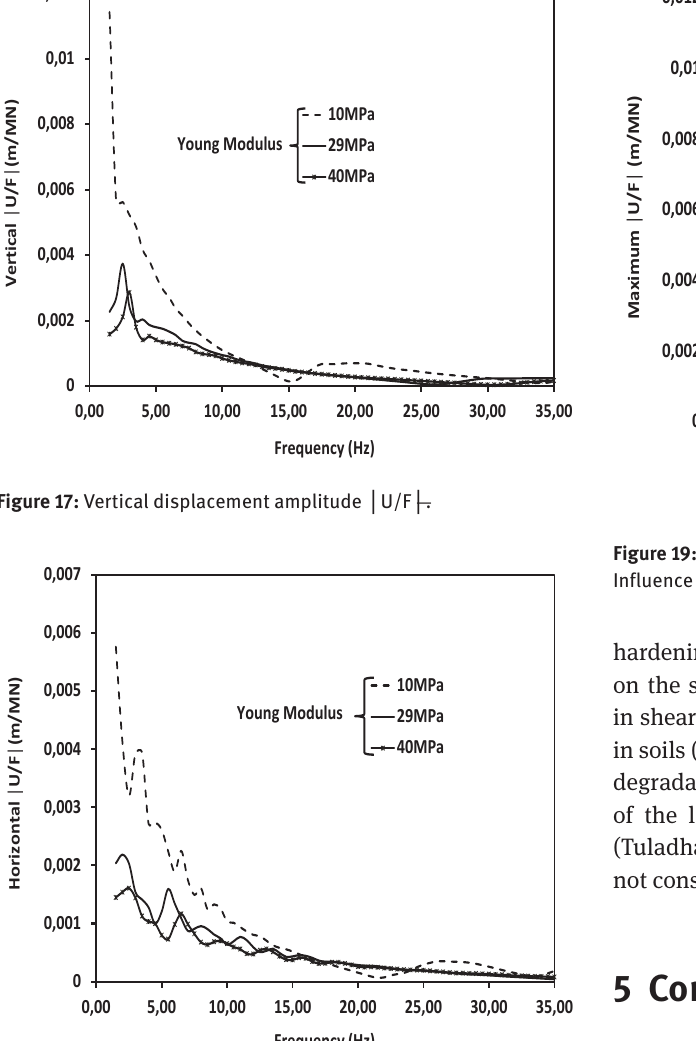
Figure 18: Horizontal displacement amplitude │ U/F │ ̶. Figure 18 Horizontal displacement amplitude │U/F│̶ Figure 18 Horizontal displacement amplitude │U/F│̶